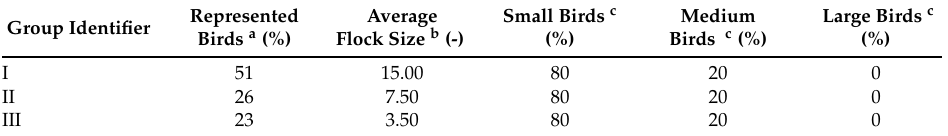
Table 3. Determined flock size groups within the range of the avian radar (0–200 m) during night time.